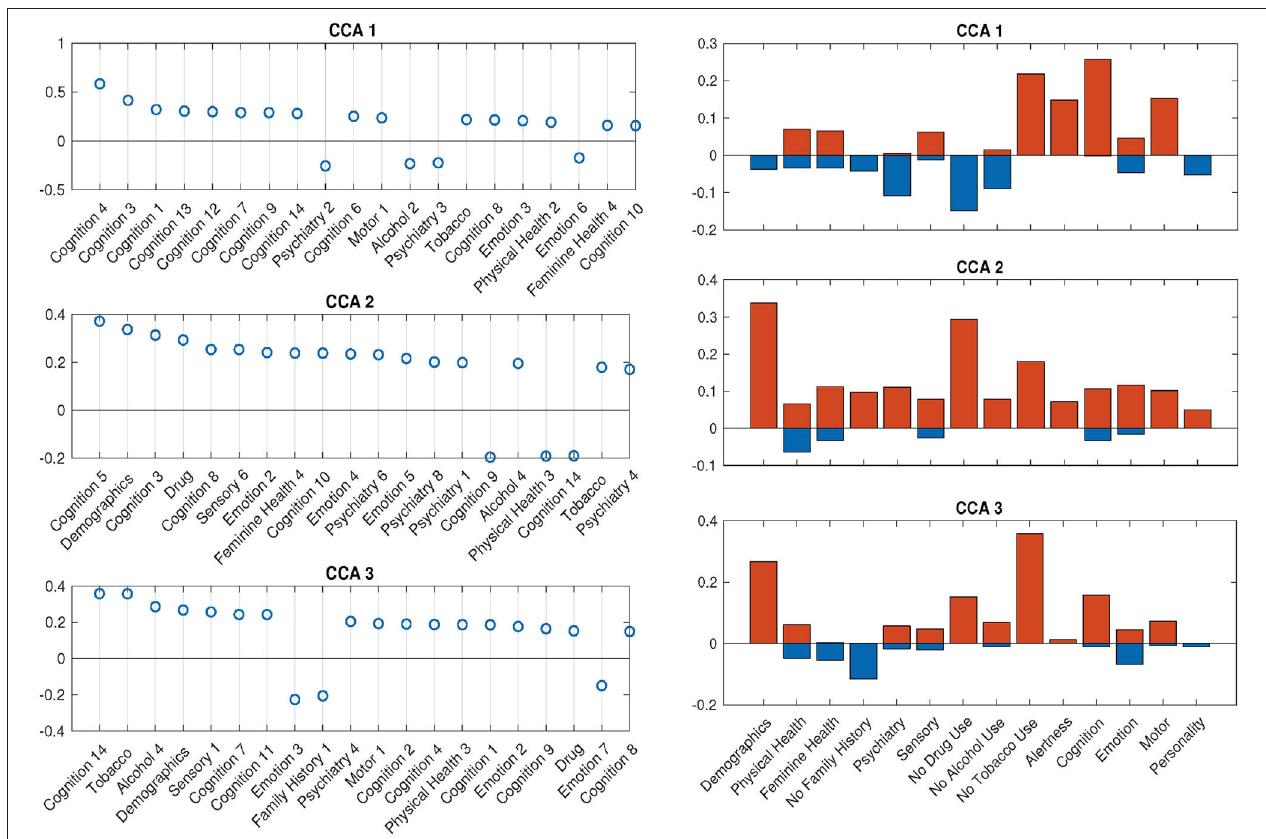
FIGURE 6 | SM canonical loadings on the CCA input for 3 significant canonical variables. The left set of figures shows top 20 loadings for 3 significant canonical variables, respectively. One can combine with Table 2 to better understand the factors on the x-axis. The right set of figures show the mean of all positive loadings (red bars) and the mean of all negative loadings (blue bars) within each sub-domain for the 3 significant canonical